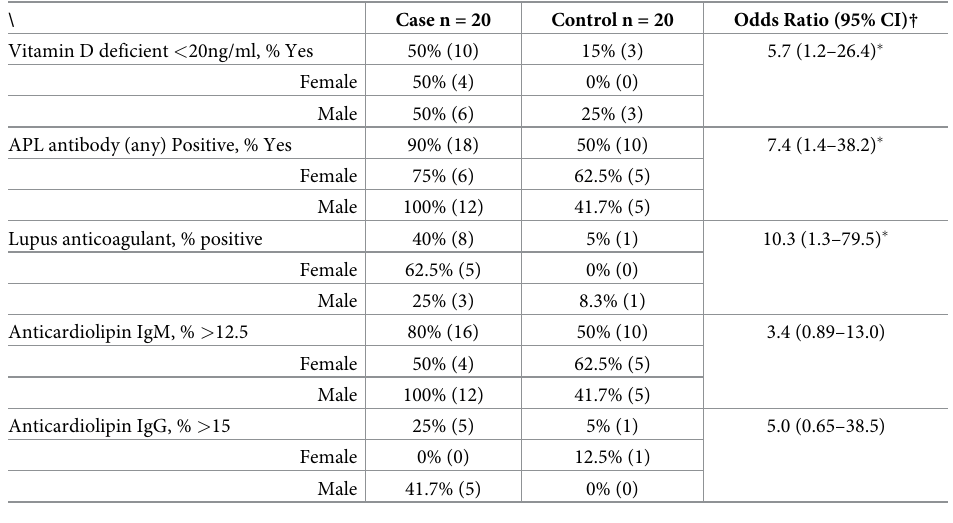
Table 3. Primary measure analyses.